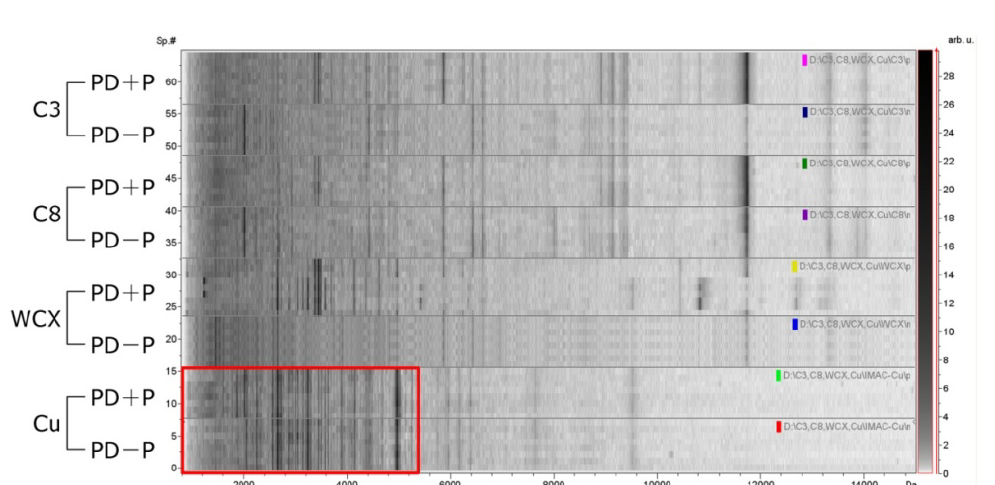
Figure 1. Protein profiles obtained with various chemical affinity beads. Peptides and proteins were captured by magnetic bead-based technology using C3, C8, weak cation exchange (WCX), and immobilized metal-affinity chromatography (IMAC-Cu) beads. In each panel, the compiled protein spectra from the PD + P and PD − P samples for each bead type are shown with the density plots of individual peritoneal dialysis effluent (PDE) profiles. X -axis, the calculated molecular mass ( m / z values); Y -axis, relative intensity of specific samples. The differential density along the x -axis represents the specific peptide that distinctly presents in the samples. IMAC-Cu shows adequate protein profiles across all beads (labeled with a red